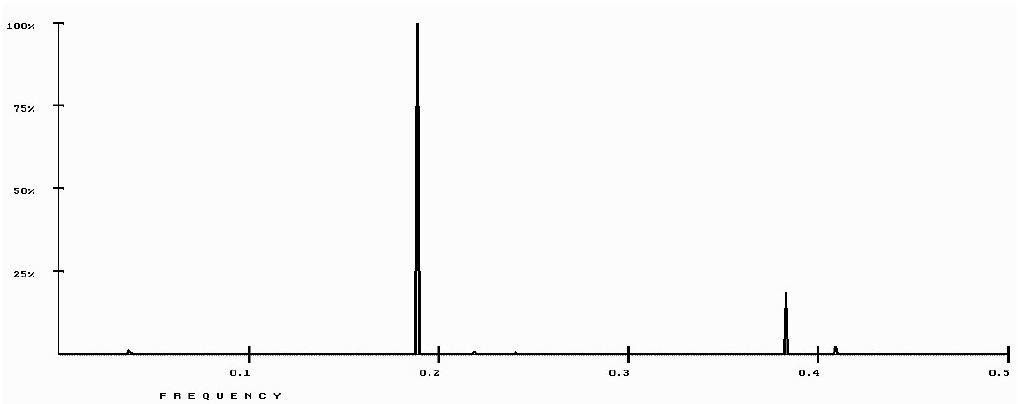
Figure 2. RRM cross-spectrum of parathyroid hormone proteins and parathyroid hormone receptor1 proteins. The prominent common characteristic frequency for these proteins is at f2 = 0.1885 ± 0.0108, which represents an electromagnetic radiation wavelength of about 1066 nm.